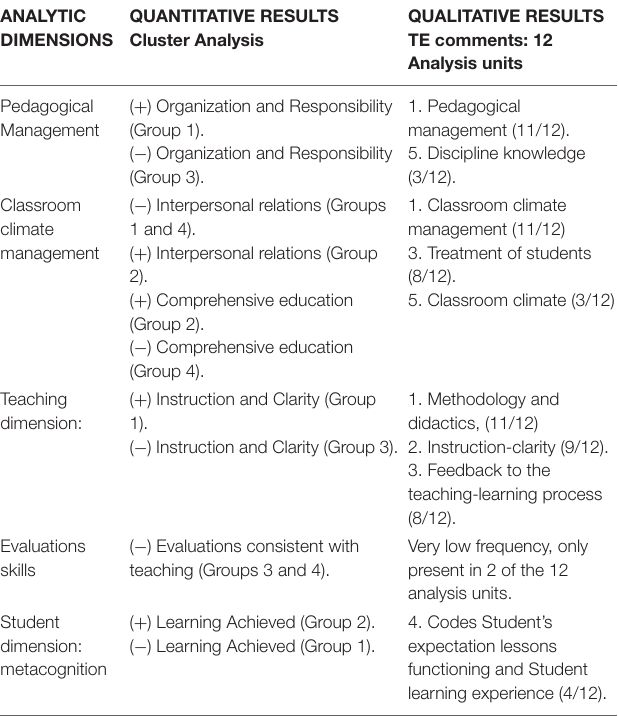
TABLE 4 | Result-synthesis mixed-methods analysis. ANALYTIC QUANTITATIVE RESULTS DIMENSIONS Cluster Analysis